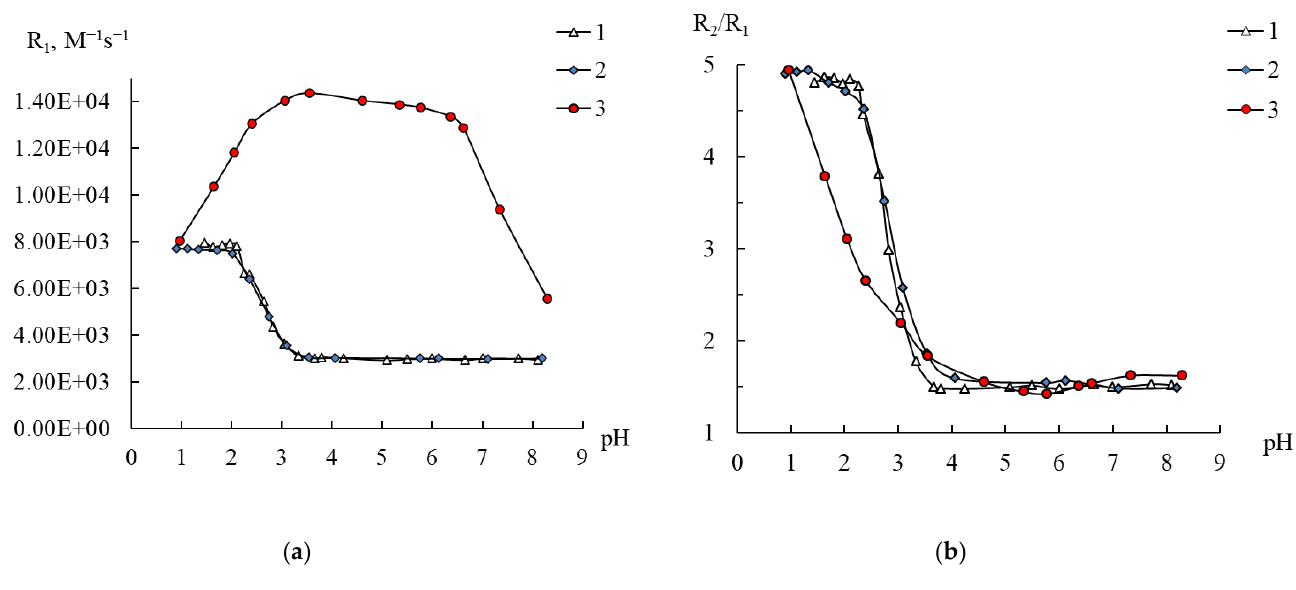
Figure 9. Changes in the relaxation efficiency R 1 ( a ) and the R 2 /R 1 ratio ( b ) as a function of the pH of Mn(II)-EDTA systems (1), compound 3—EDTA (2) aqueous solution 3 (3). С Mn(II) 0.2 (2), 0.4 mM (1, 3), EDTA 1 mM (1, 2).